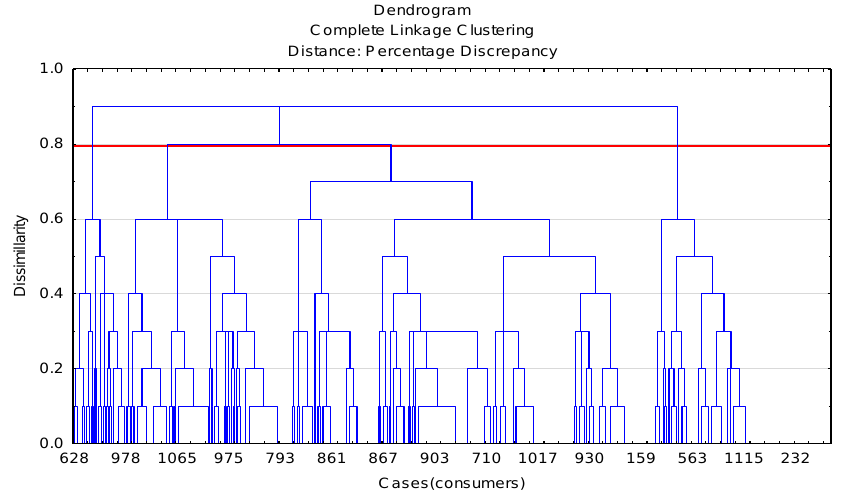
Figure 2. Case agglomeration results for non-game eaters.